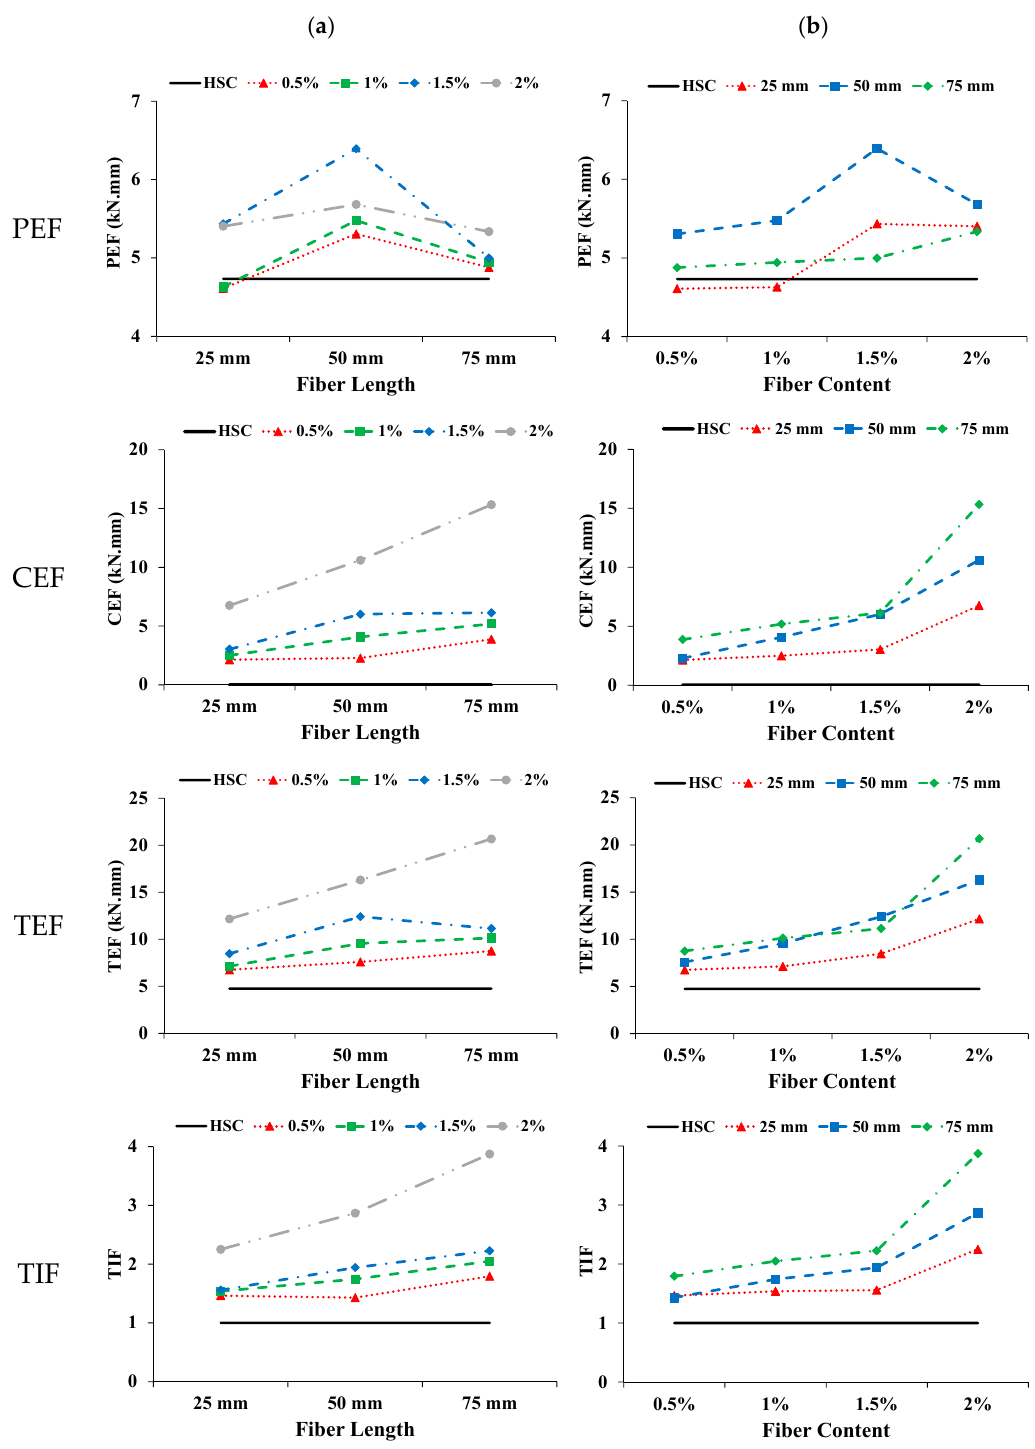
Figure 14. Influence of coconut fiber on PEF, CEF, TEF, and TIF: ( a ) Length; ( b ) Content .